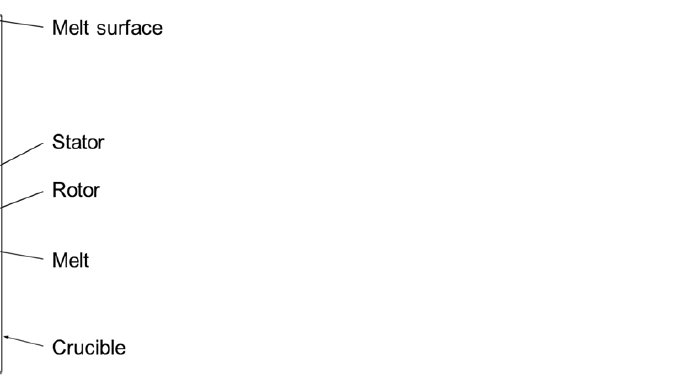
Figure 6. Schematic diagram of the high shear melt conditioning (HSMC) process. Arrows without labels indicate the flow of molten metal during processing.